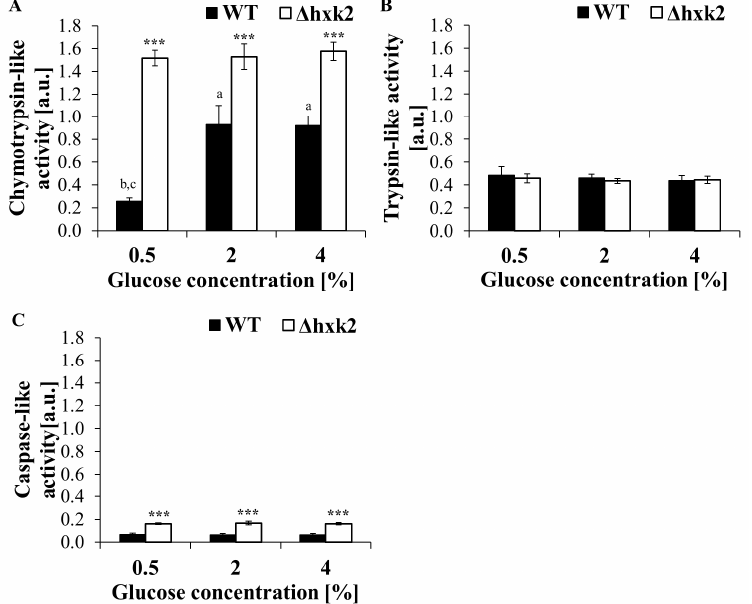
Figure 7. Proteasomal activity in yeast cells cultured in conditions with di ff erent glucose concentration. ( A ) Chymotrypsin-like activity determined with Suc-LLVY-AMC fluorogenic peptide, ( B ) trypsin-like activity determined with Z-ARR-AMC fluorogenic peptide; ( C ) caspase-like activity determined with Z-LLE-AMC. The degradation of fluorogenic peptide was measured by monitoring the fluorescence of the reaction product, free 7-amino-4-methylcoumarin (AMC). The rate of fluorescence increase was measured at λ ex = 350 nm and λ em = 440 nm. The values are expressed in arbitrary units. *** p < 0.001 as compared to the WT strain; a—di ff erent to medium with 0.5% glucose, b—di ff erent to medium with 2% glucose, c—di ff erent to medium with 4% glucose.